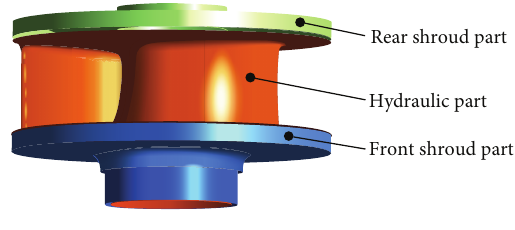
Figure 4: Impeller